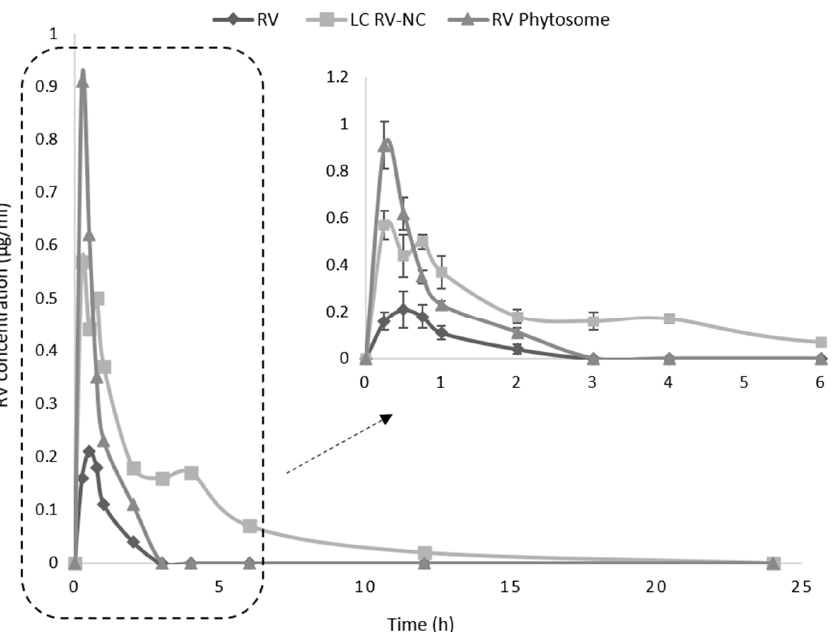
Figure 6. Plasma concentrations of trans -resveratrol vs. time after the oral administration of RV coarse powder (RV), lipid-coated RV nanocrystals (LC RV-NC) and RV Phytosome ® .